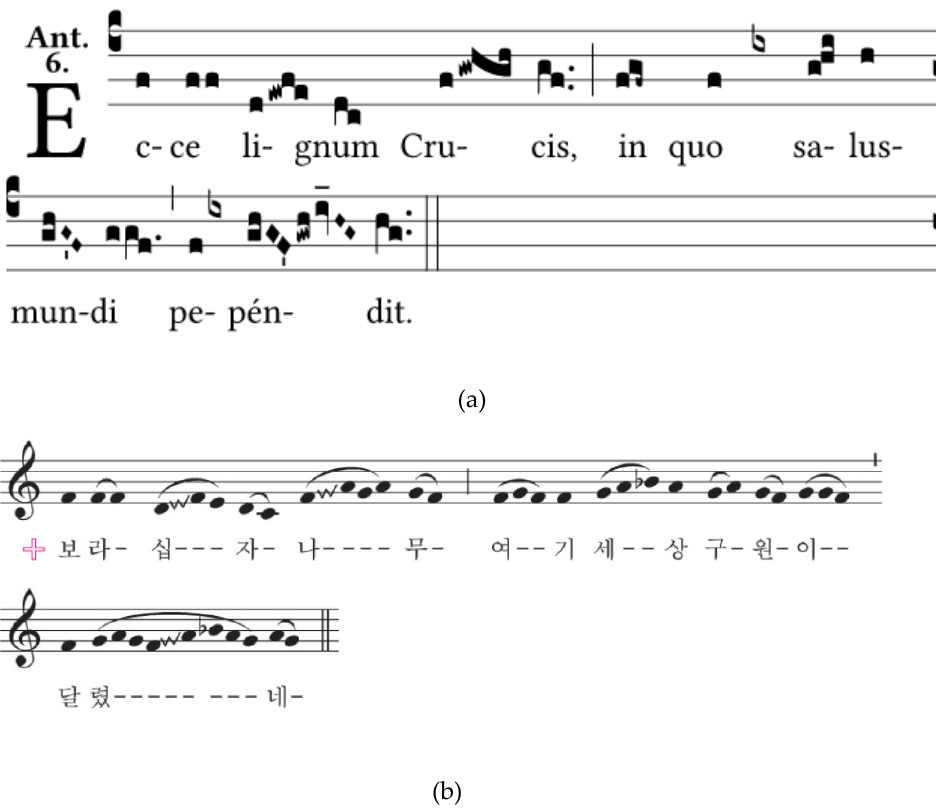
Figure 6. Comparison between the original Latin ( a ) and Korean ( b ) scores of “Ecce lignum Crucis” (A Database of Gregorian Scores 2021; Catholic Conference of Korea 2021).